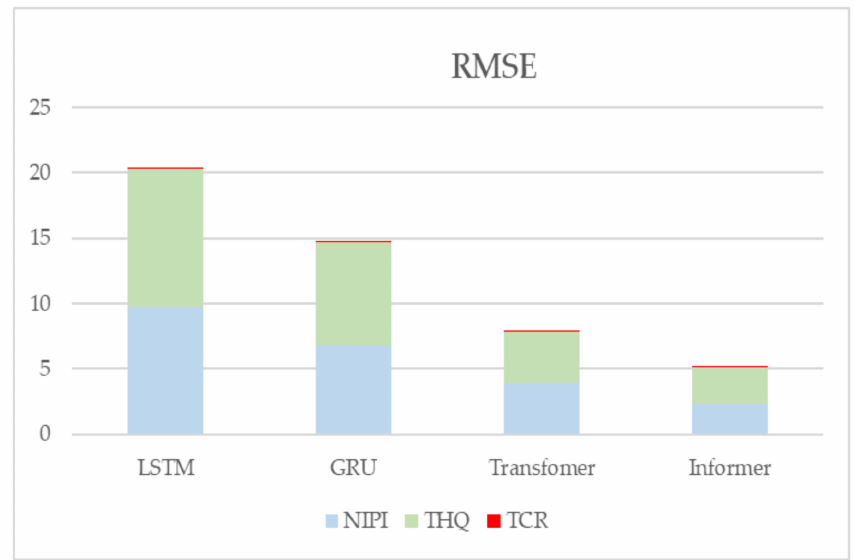
Figure 16. Predictive evaluation metric RMSE for NIPI, THQ, and TCR.